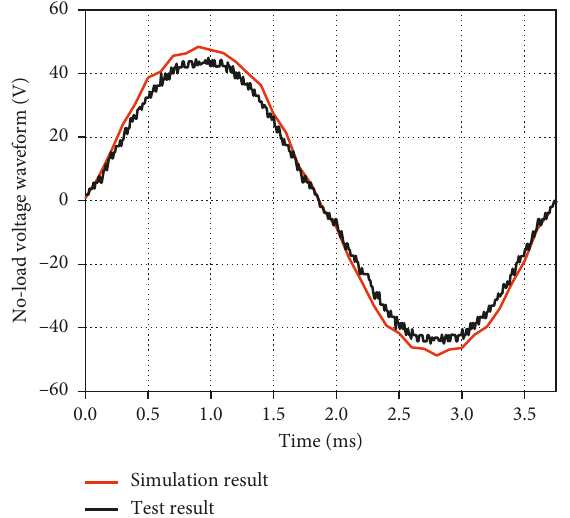
Figure 25: Comparison between test results and simulation results of the no-load voltage waveform of HEG.